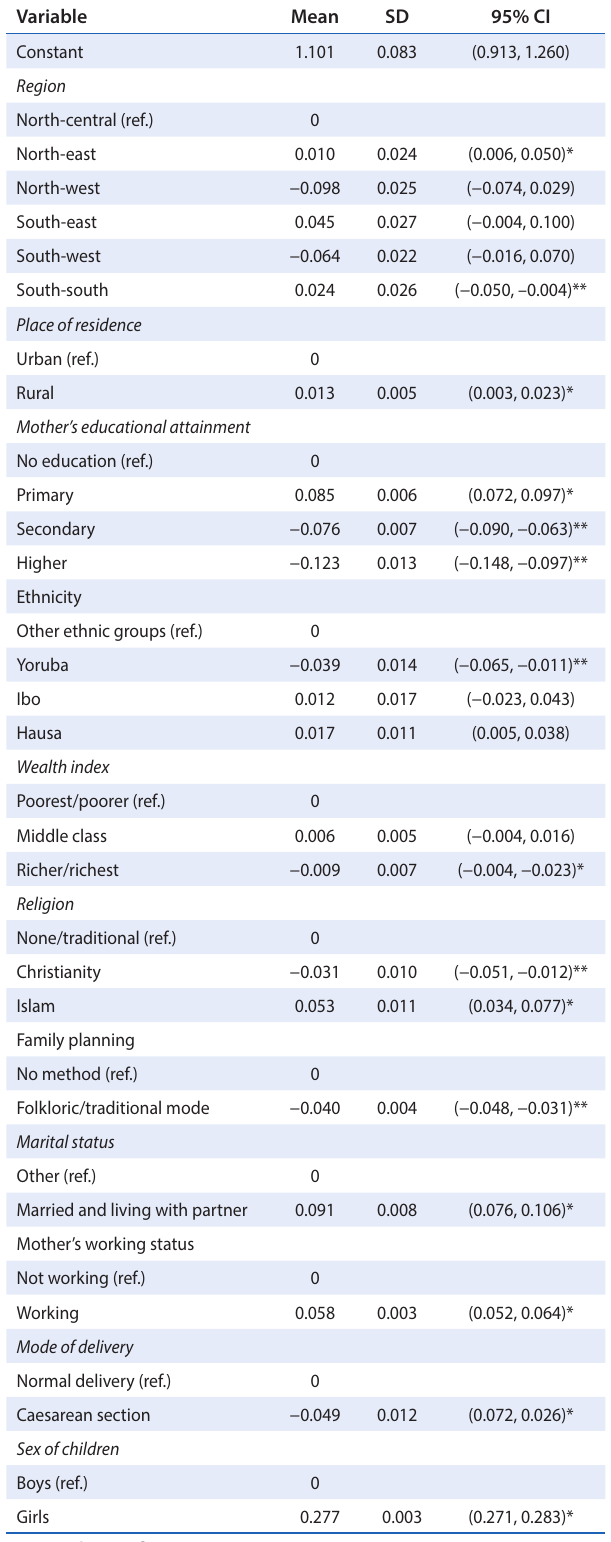
Table 1: Posterior estimates within 95% credible interval (CI)